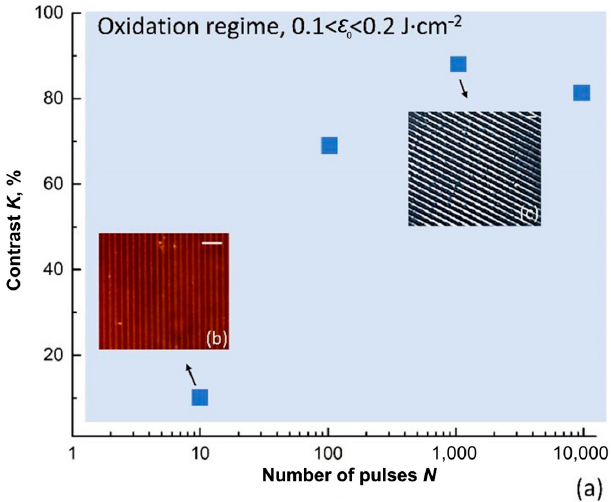
Figure 5. Figure 5. ( a ) The dependence of the optical contrast of fabricated stripes on the number of laser pulses ( N ). The interference pattern was formed in the oxidation regime, 0.1 < ε 0 < 0.2 J · cm − 2 . The inserted micrographs taken at a constant exposure time ( b , c ) shows the formed stripes at 10 and 10 3 pulses. The scale bar is 5 µ